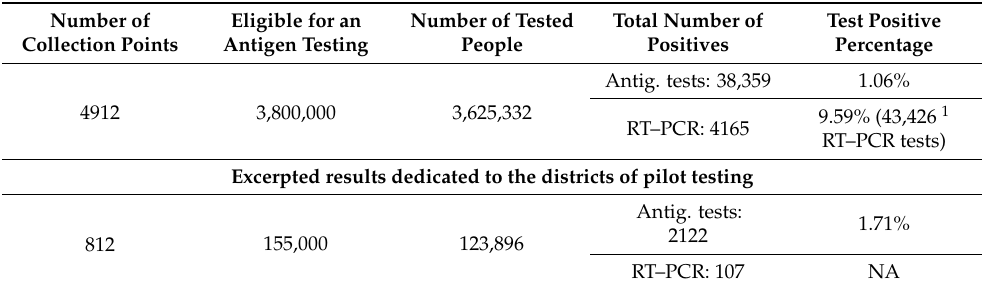
Table 5. Summary of nationwide testing (from 31 October–1 November 2020) [20].